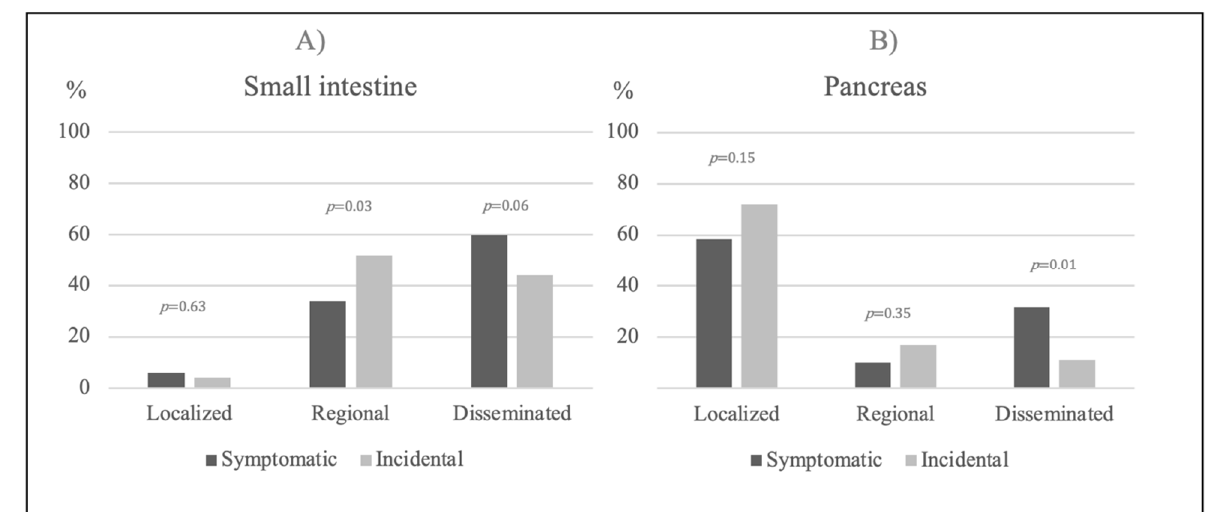
Figure 3. Disease stage symptomatic vs. incidental findings in the entire cohort. ( A ) Disease stage of small intestinal NETs when comparing symptomatic vs. incidental findings in the entire cohort (2010, 2011, 2019 and 2020). ( B ) Disease stage of pancreatic NETs when comparing symptomatic vs. incidental findings in the entire cohort. The p -value illustrates the difference between the symptomatic and incidental findings. Abbreviation: Neuroendocrine Tumor (NET).